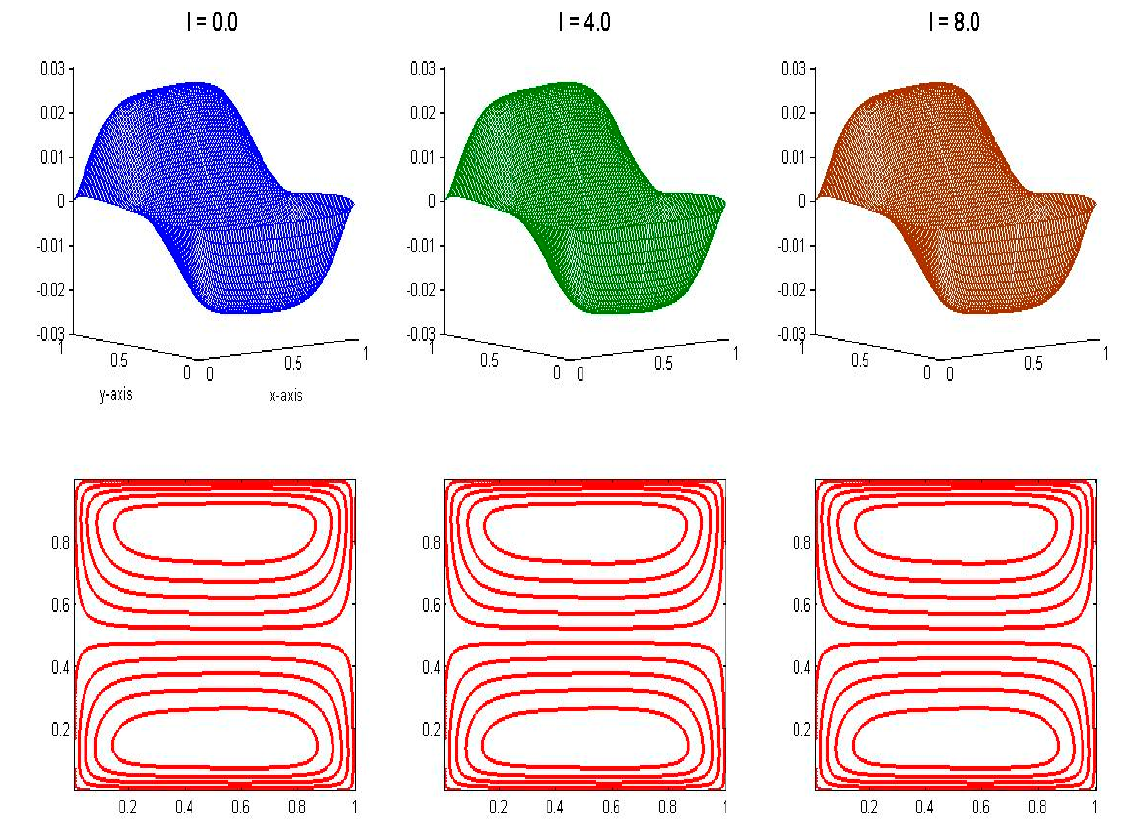
Figure 6. Velocity contours for altered inertial parameter.